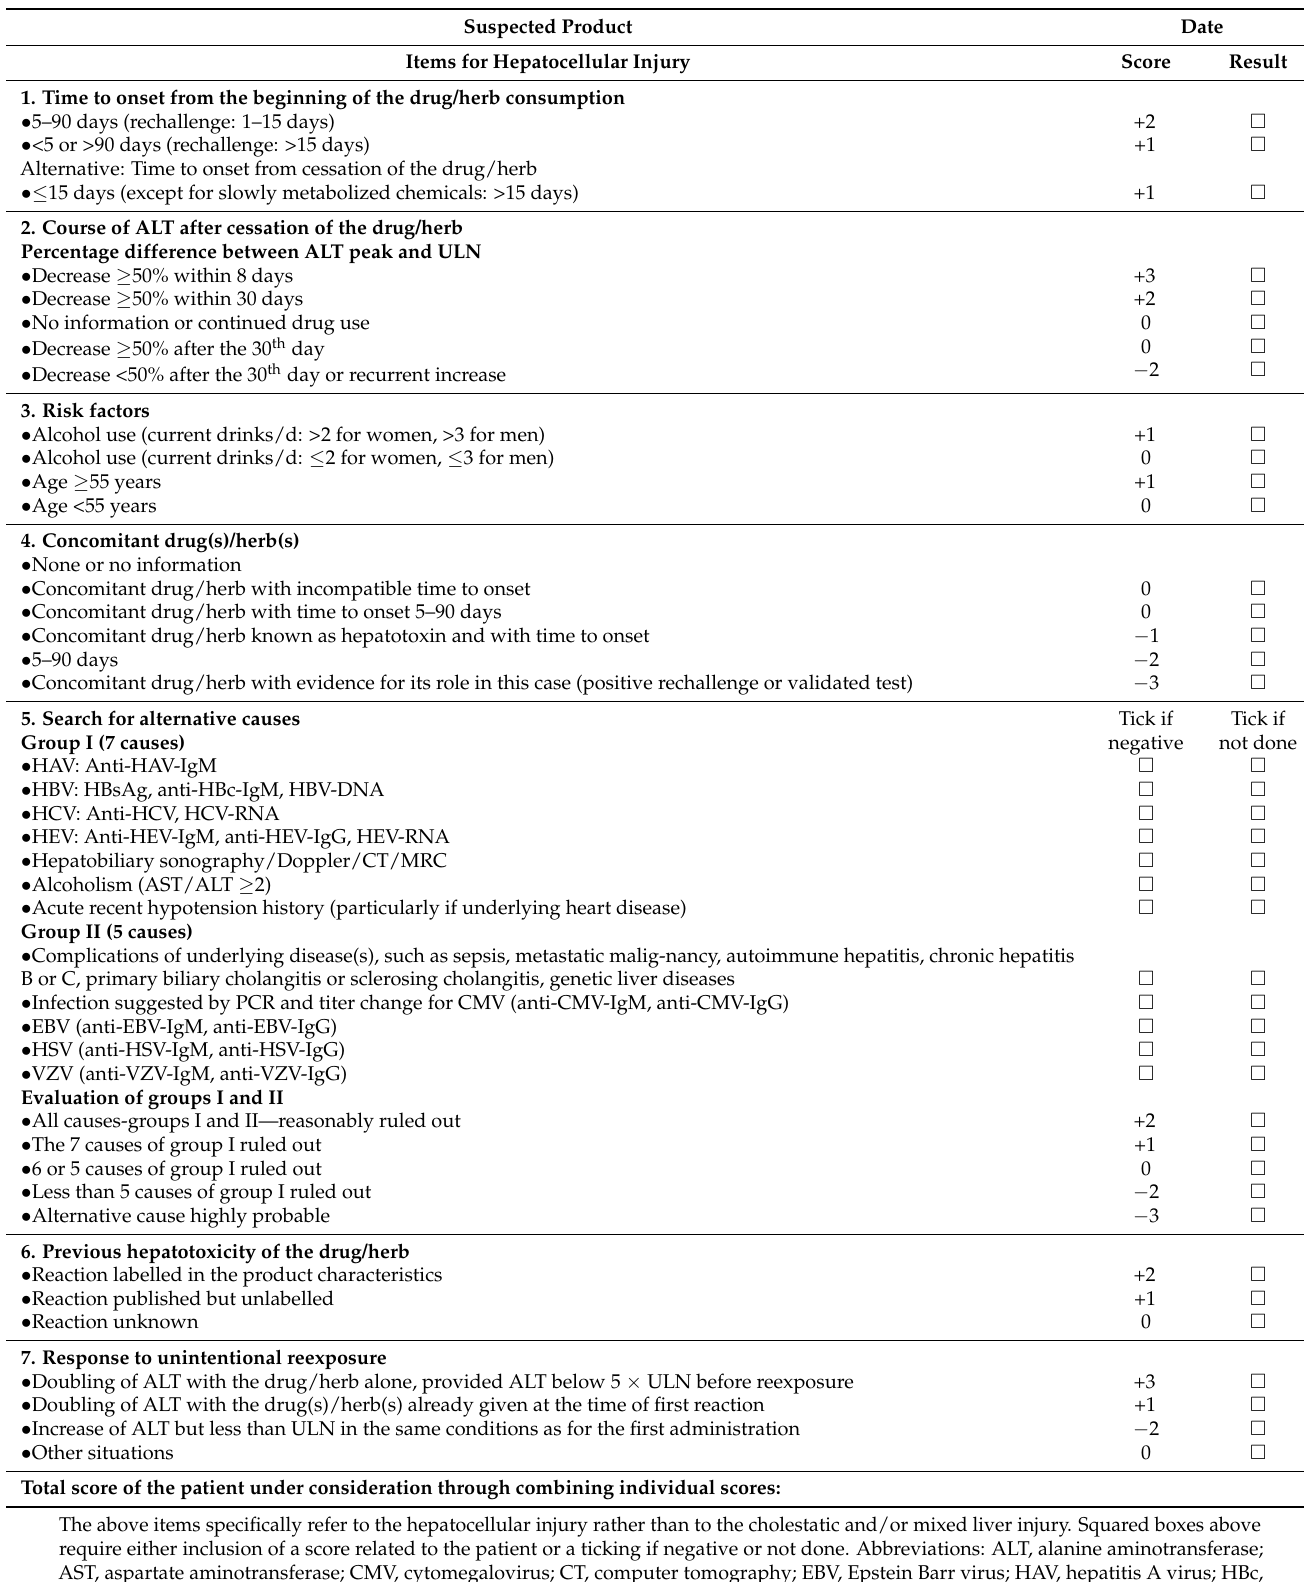
Table 6. The updated RUCAM scale for the hepatocellular